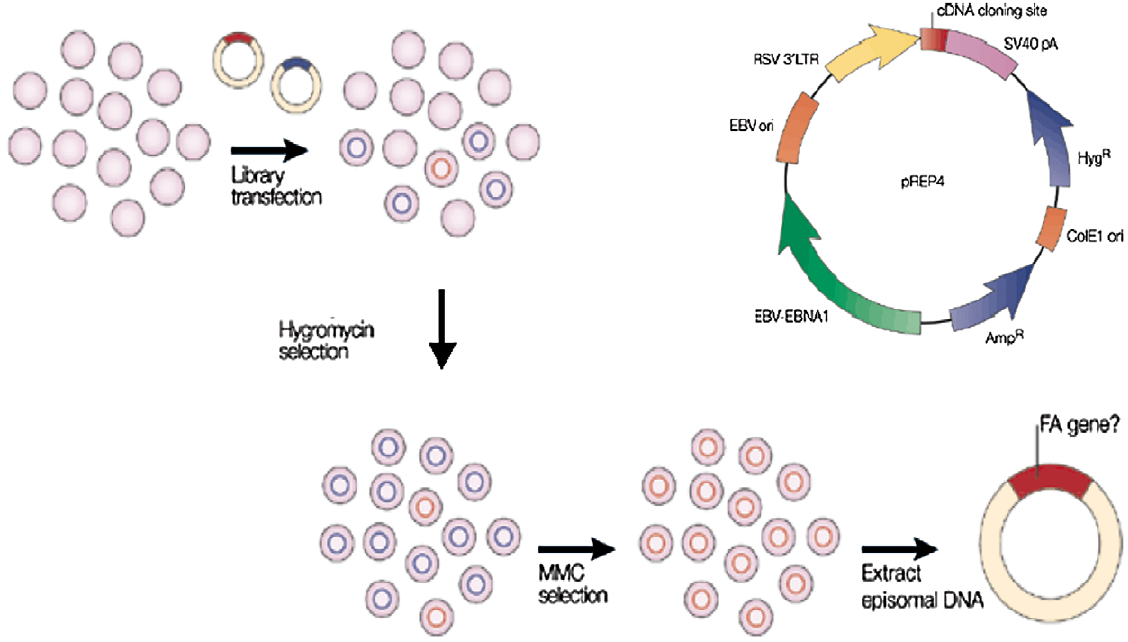
Fig. 3. Complementation cloning in FA. Different cDNAs, contained in a library derived from wild type human lymphoblasts, are cloned into the pREP4 vector. This vector is introduced into a MMC-sensitive FA cell line. First, a hygromycin selection is performed to select for those cells that have taken up a vector. Secondly, this cell population is selected for those cDNAs that confer MMC resistance. This MMC resistant cell population is likely to contain the FA gene defective in the original cell line. The different cDNAs in this population, all candidate-FA genes, are then extracted and examined. Detection of mutations in a candidate gene in the patient provides final proof that a new FA gene has been identified. (Figure reproduced with permission from Nature Reviews Genetics (Joenje and Patel) [67] c (cid:2) (2001) Macmillan Magazines Ltd.)